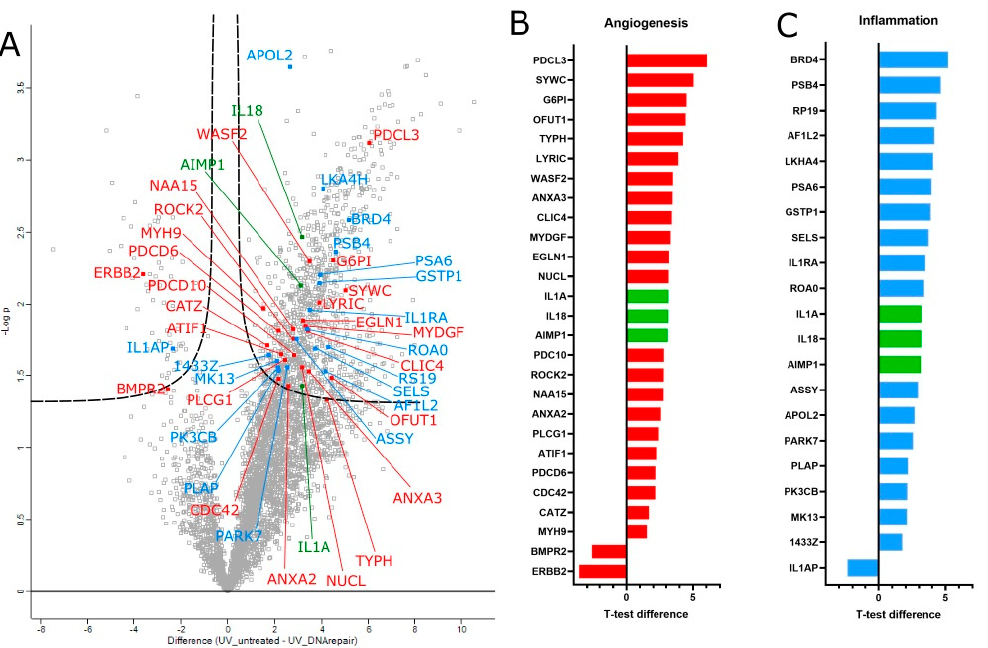
Figure 4. ( A ) Volcano plot analysis for differentially expressed proteins in human limbal epithelial cells across three biological replicates, comparing UV irradiated with and without T4 endonuclease V treatment. The proteins are labelled with their gene names. The difference in the means of the expressed proteins on the x -axis vs. the statistical significance ( − log p -value) on the y -axis is shown. Out of the 1176 statistically significant proteins, 20 inflammation-related proteins (blue) and 26 angiogenesis proteins (red) were highlighted. Three proteins were found to be involved in both functions (green). The T -test difference values for the two groups of interest are represented in a bar chart for angiogenesis-related proteins ( B ) and inflammatory-related proteins ( C ).